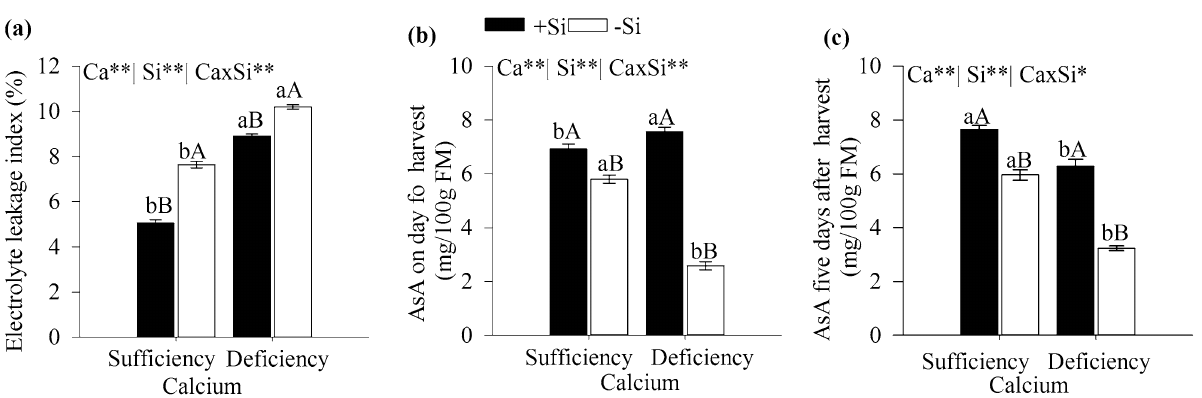
Figure 3. Electrolyte leakage index ( a ), ascorbic acid content on harvesting day ( b ), and ascorbic acid content (AsA) five days after harvesting ( c ) of cabbage grown under Ca sufficiency and deficiency, with (− Si) and without added Si (+ Si). F test was applied: *( p ≤ 0.05) and **( p ≤ 0.01). The Student t means comparison test was applied. Lowercase letters ( a , b ) indicate significant differences to calcium within the same level as Si ( p < 0.05). Uppercase letters ( A , B ) indicate significant differences for silicon within the same level as Ca ( p < 0.05). The bars represent the mean standard error. n =